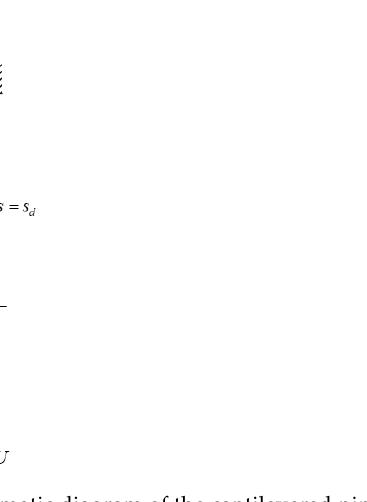
Figure 1. Schematic diagram of the cantilevered pipe with a dry friction restraint.